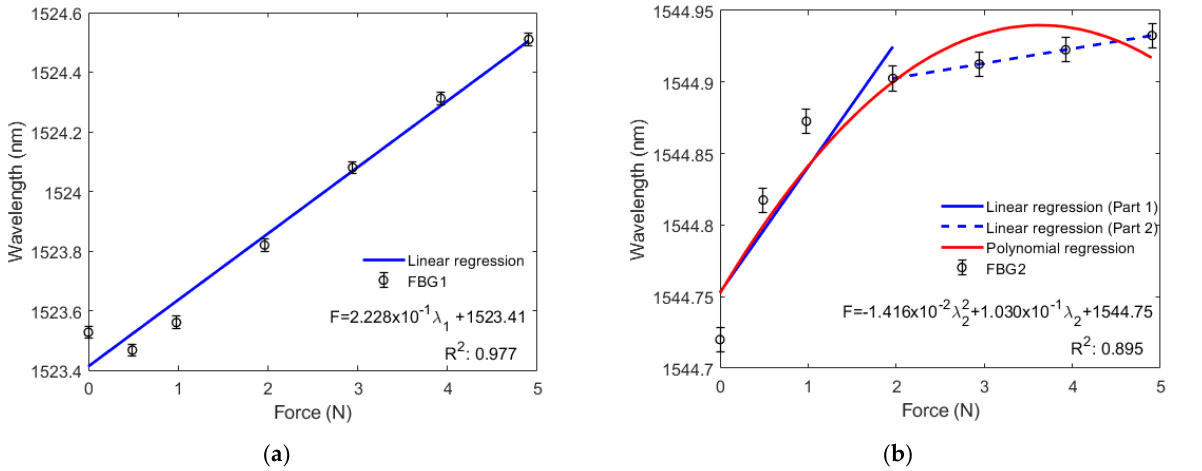
Figure 5. ( a ) Bragg wavelength shift as a function of the bending force for FBG1; ( b ) Bragg wavelength shift as a function of the bending force for FBG2.